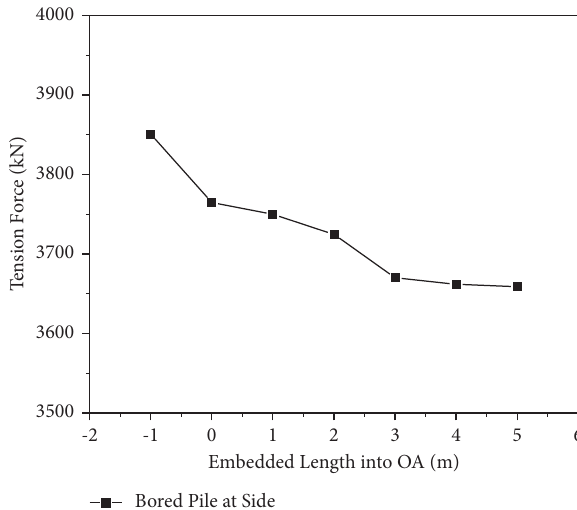
Figure 11: The effect of retaining wall embedded length into OA on tension force of bore pile at side.